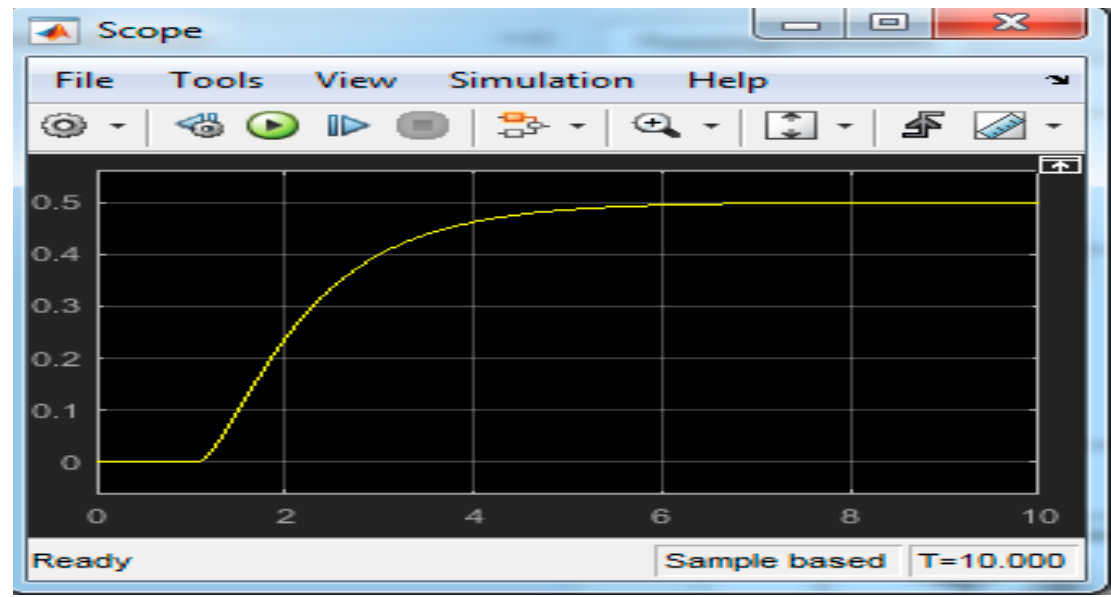
Figure 17. Simulation of diesel engine speed controller when decreasing the setting value (Reference Speed).